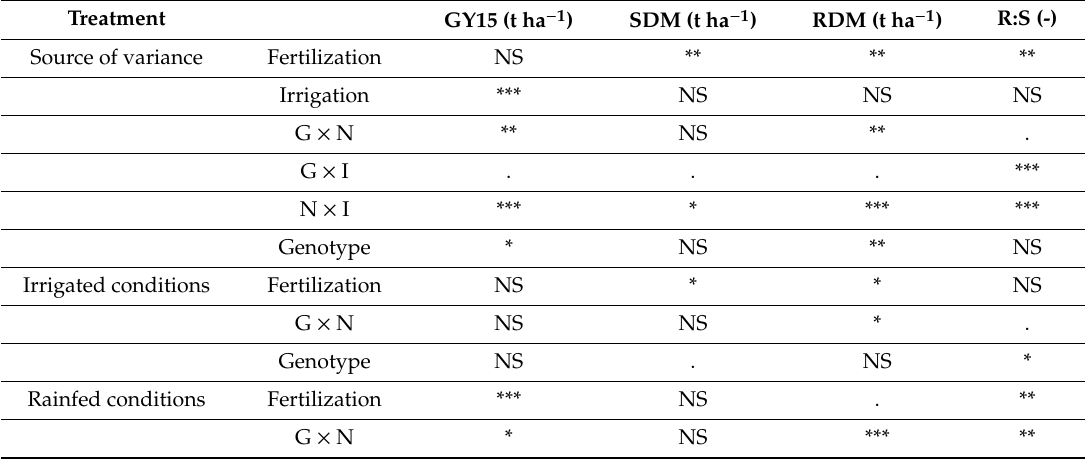
Table 2. Analysis of variance (ANOVA) of the Irrigation and Nitrogen (I, N) treatments for wheat cultivars on the measured variables (Yield: GY15, Shoot dry mass at anthesis: SDM, Root dry mass at anthesis: RDM, Root / shoot ratio at anthesis: R:S) for the four di ff erent